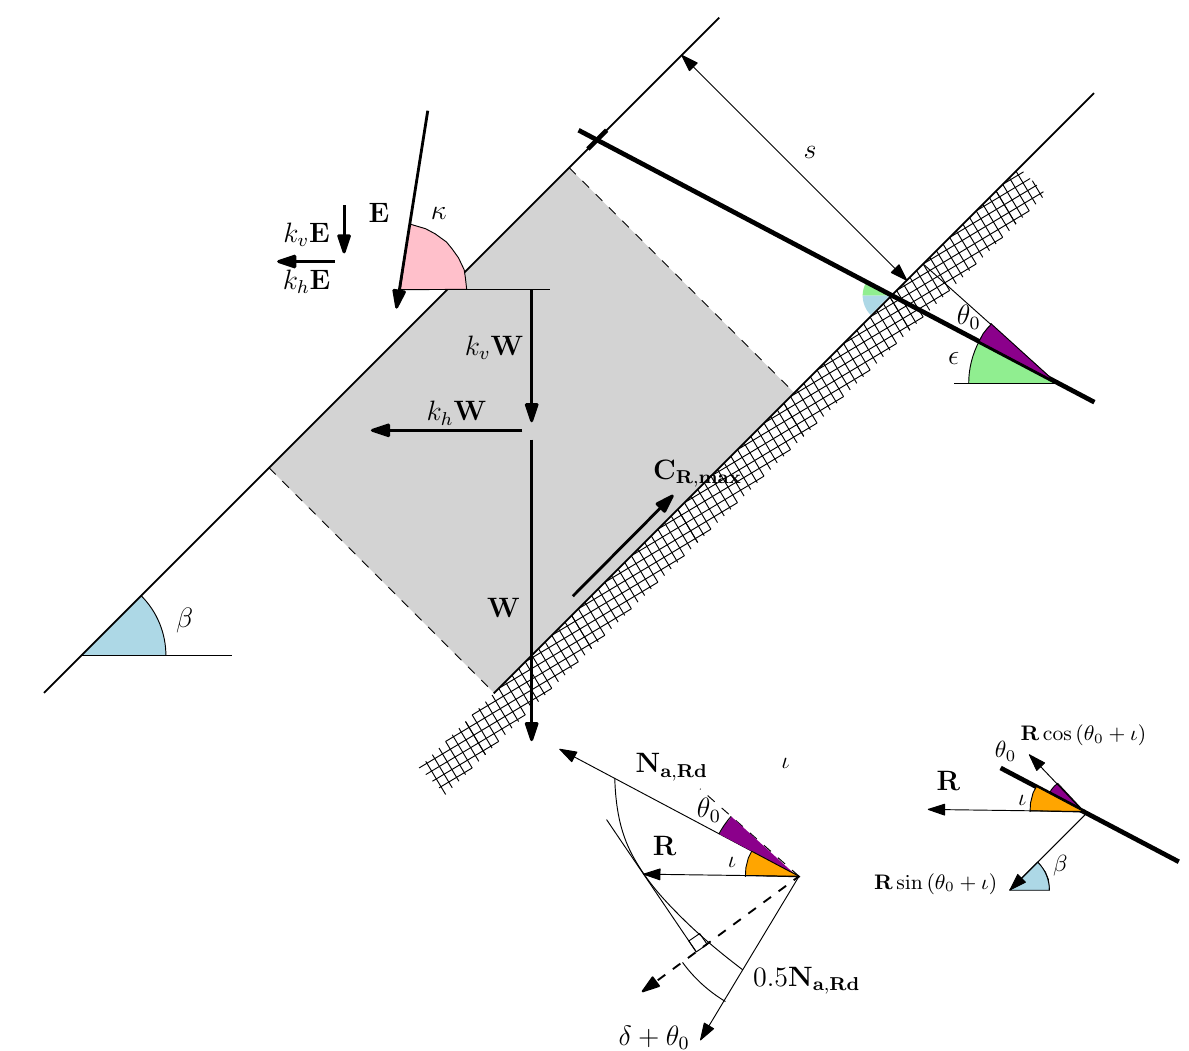
Figure 6. Sketch of the force acting on the sliding surface considering global instability of the cortical band; E represents an external